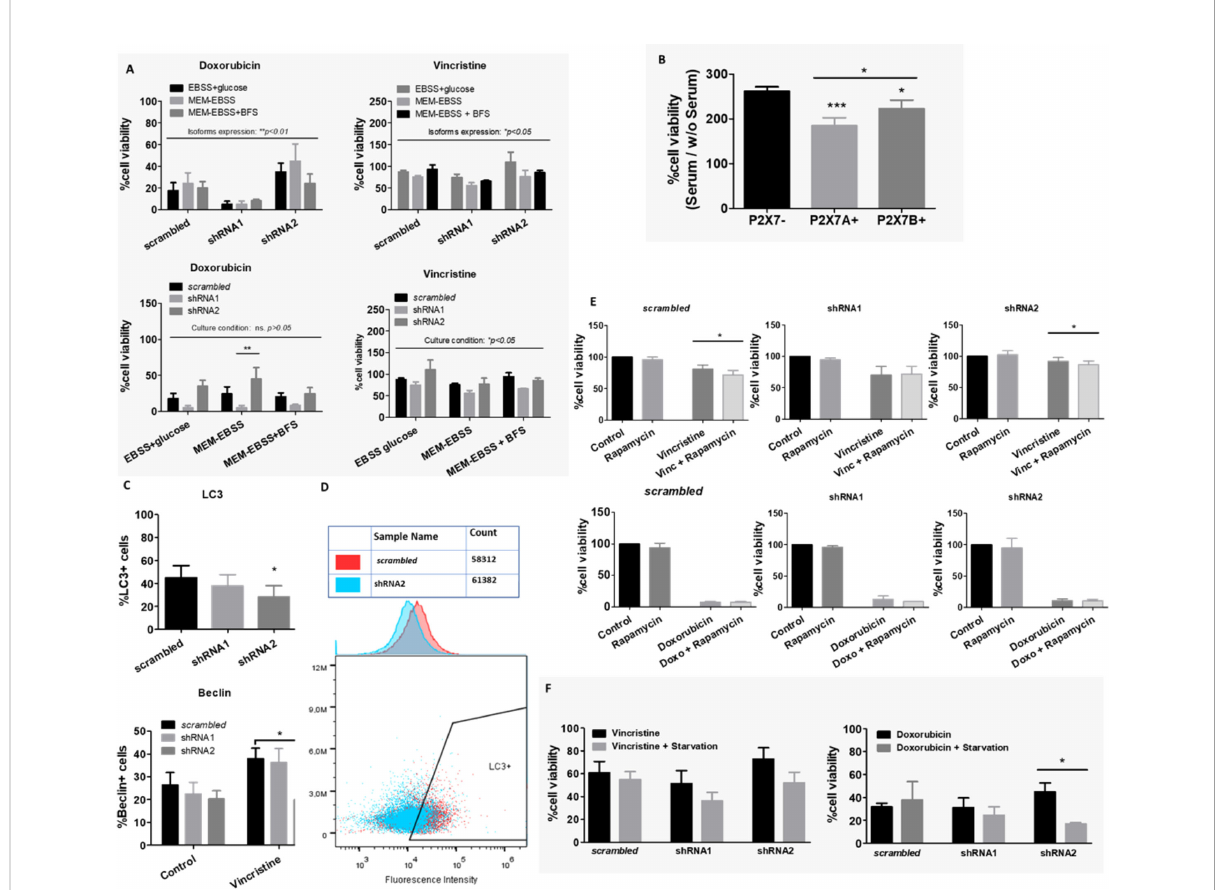
FIGURE 6 Culture conditions and autophagy in drug resistance. (A) Contributions of culture conditions and P2X7 receptor isoform silencing to the ACN cell drug response to doxorubicin (doxo) or vincristine (vinc) (n=3). (B) Cell viability percentage ratio of HEK 293 cells grown in serum- containing medium over serum deprivation, representing the serum-induced growth of HEK 293 cells according to the presence of P2X7 receptor isoforms (n=3). (C) Flow cytometry measurements of cell populations expressing the autophagy markers LC3 (n=4) and Beclin (n=3). (D) Representative cytometry dot plot of LC3+ cells in the scrambled or shRNA2 cell group. (E) Cell viability measurements of ACN cells treated with vincristine (n=5) or doxorubicin (n=3) in the presence or absence of rapamycin. (F) Cell viability measurements of ACN cells treated with vincristine or doxorubicin with or without serum starvation (n=3). Values were calculated as detailed in Methods section item 5. *p<0.05; **p<0.01;